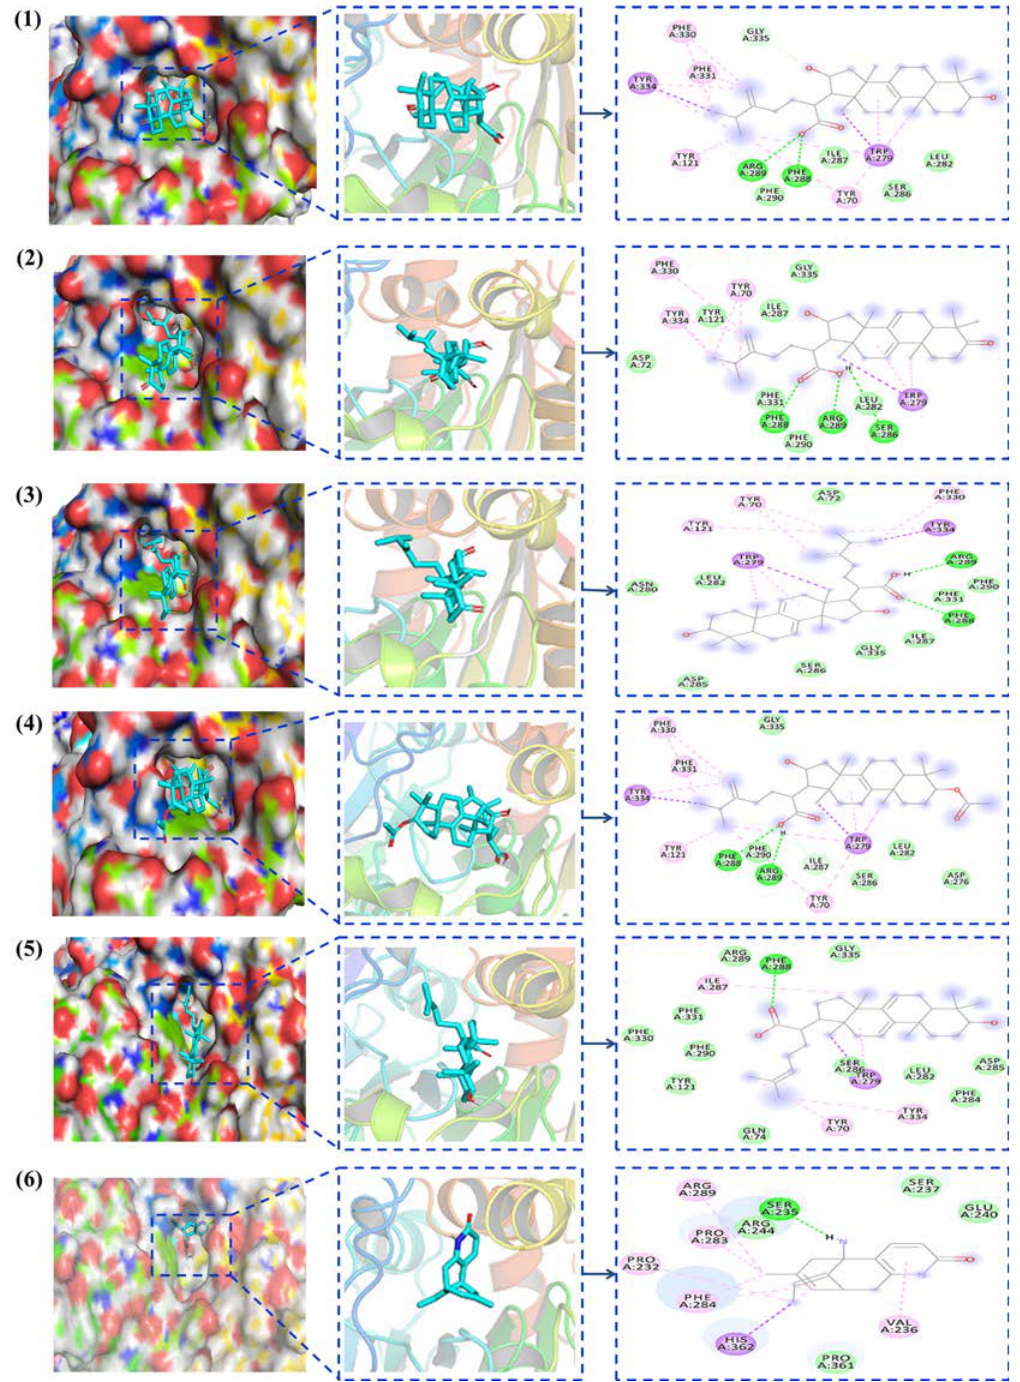
Figure 3. Molecular docking simulation of monomer active compounds and AChE. Compounds: (1) Tumulosic acid; (2) Polyporenic acid C; (3) 3 − Epidehydrotumulosic acid; (4) Pachymic acid; (5) Dehydrotrametenolic acid; (6) Huperzine